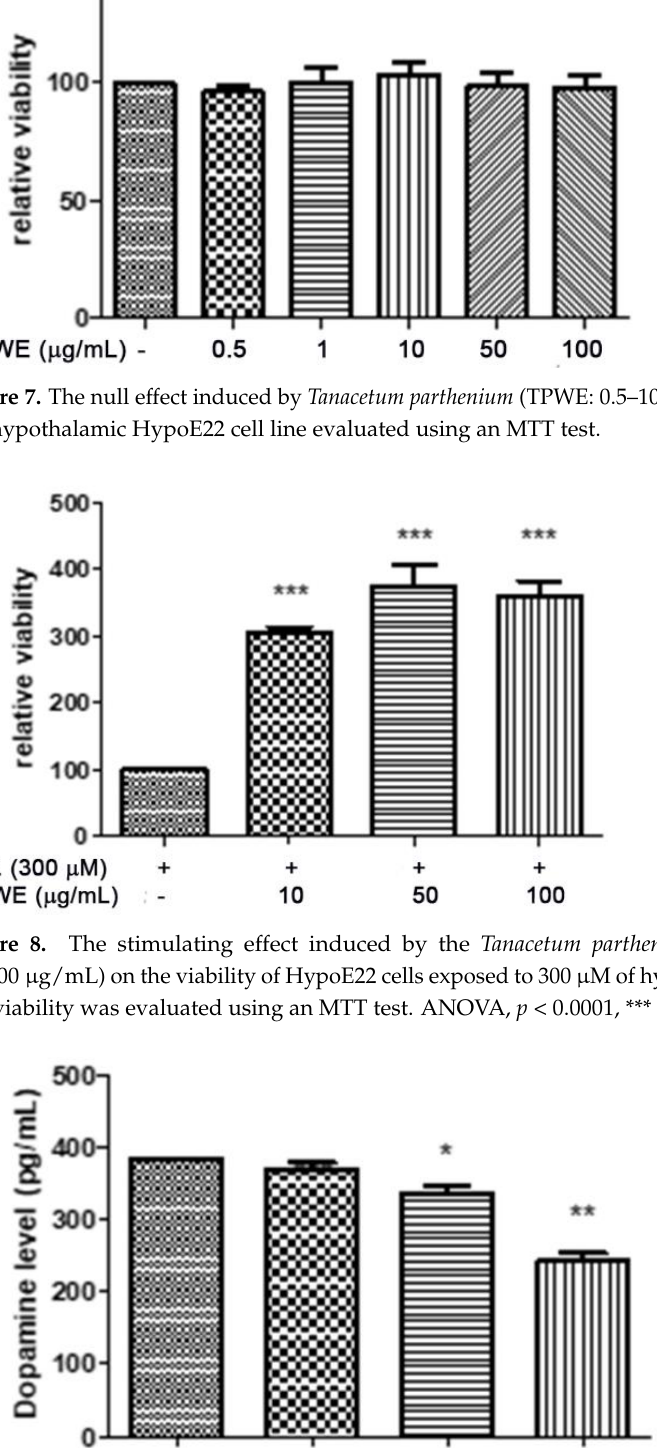
Figure 10. The inhibitory effect induced by Tanacetum parthenium (TPWE: 10–100 µg/mL) on dopa- mine transporter (DAT) gene expression in hypothalamic HypoE22 cells. ANOVA, p < 0.001; ** p < 0.01 vs. the untreated control (CTR) group.